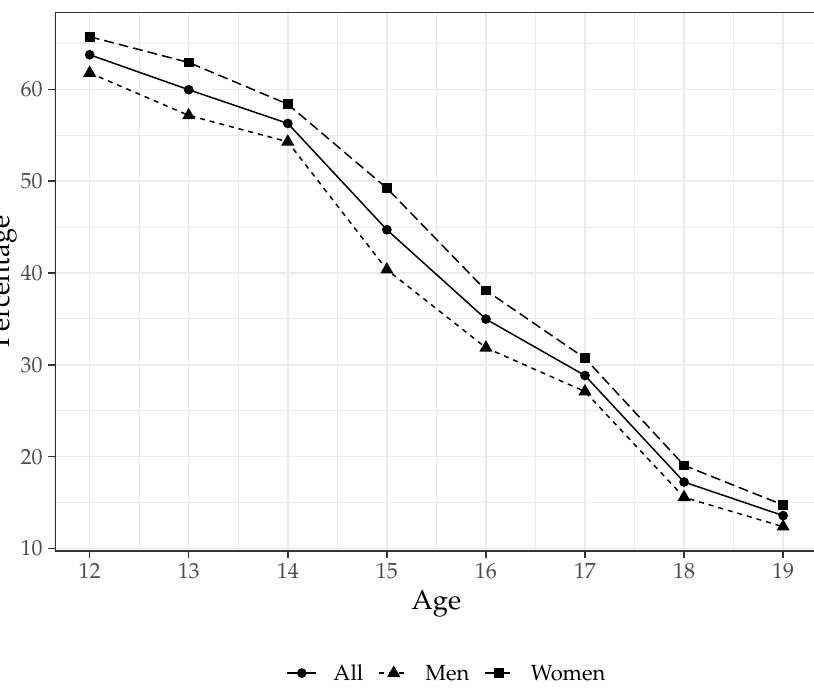
Figure 2. School attendance without delay by age and gender. Unweighted data. Prepared by